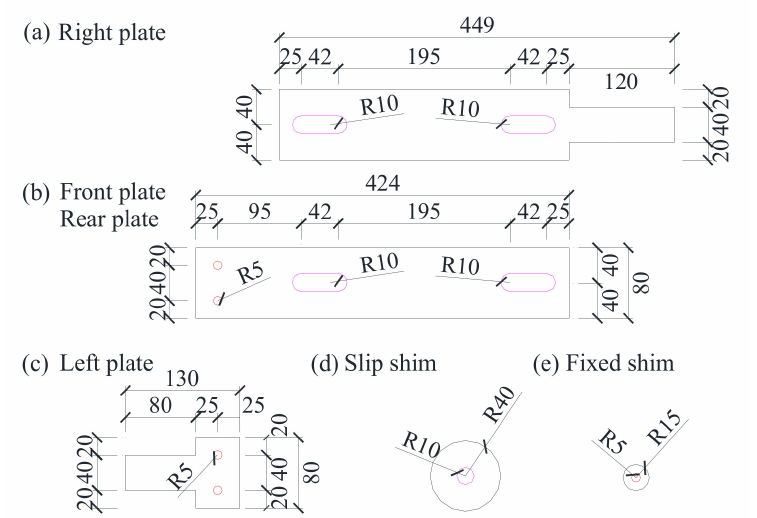
Figure 3. ( a ) right plate ( b ) front plate/rear plate ( c ) left plate ( d ) slip shim ( e ) fixed shim. Details of the self-centering SMA brace.